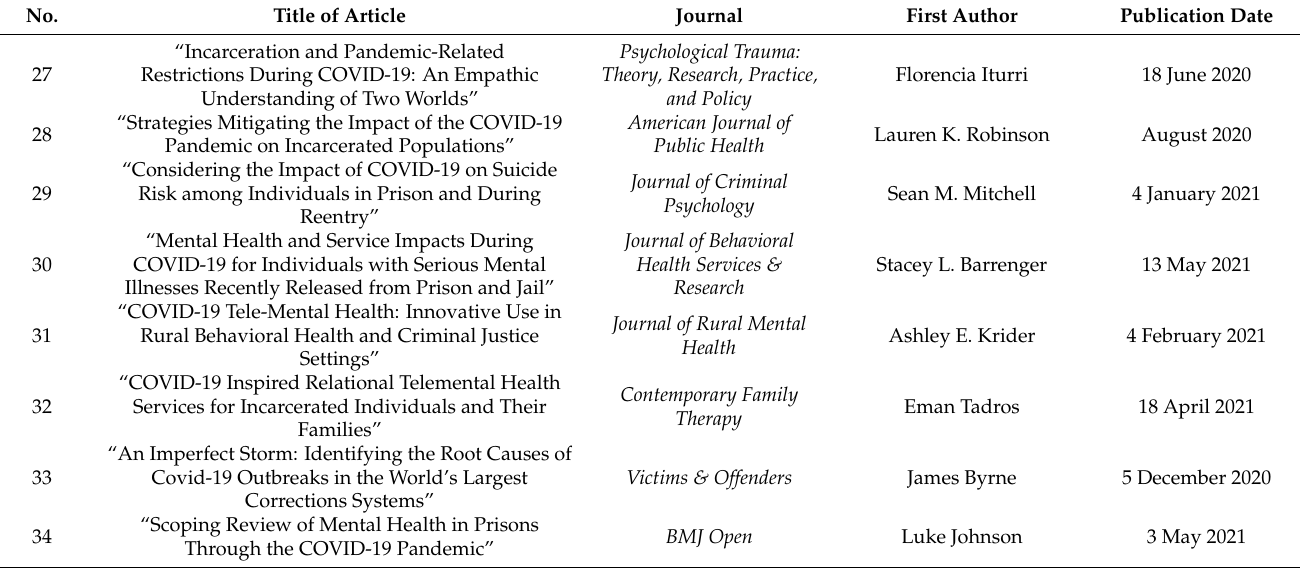
Table 2. Distribution of Peer Reviewed Literature across Intersections by Journal and Article